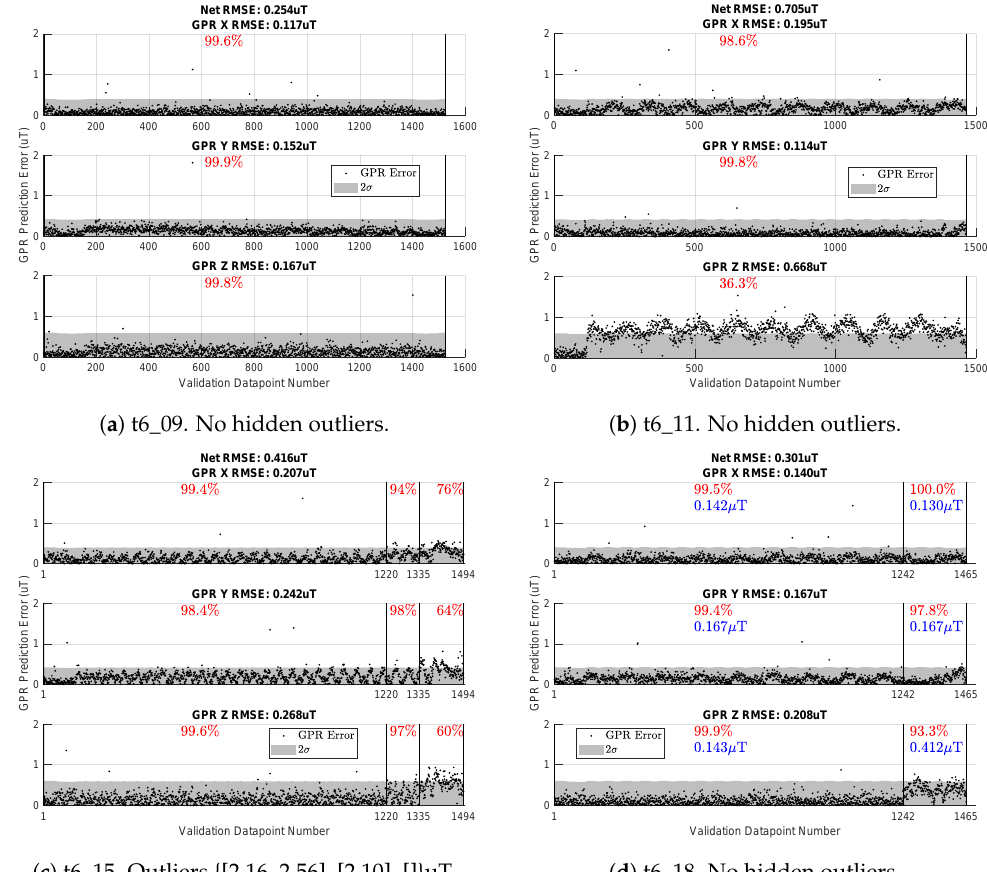
Figure 13. Consistency metric (red percentage) across four validation flights. Some error points are larger than 2 µT and are cut off in the graphs. Such outliers are listed for { [ GP x ], [ GP y ], [ GP z ] } in the respective subplot caption. Empty brackets indicate no hidden outliers for the respective GP